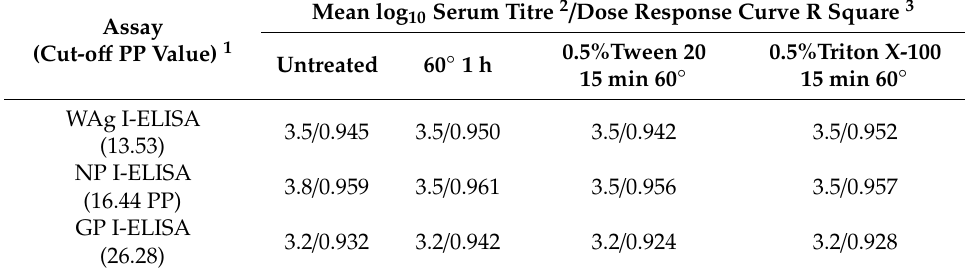
Table 5. Comparison of whole antigen (WAg), nucleocapsid (NP) and glycoprotein (GP) indirect ELISAs mean titers and analytical slopes of non-treated versus inactivated IgG EBOV positive